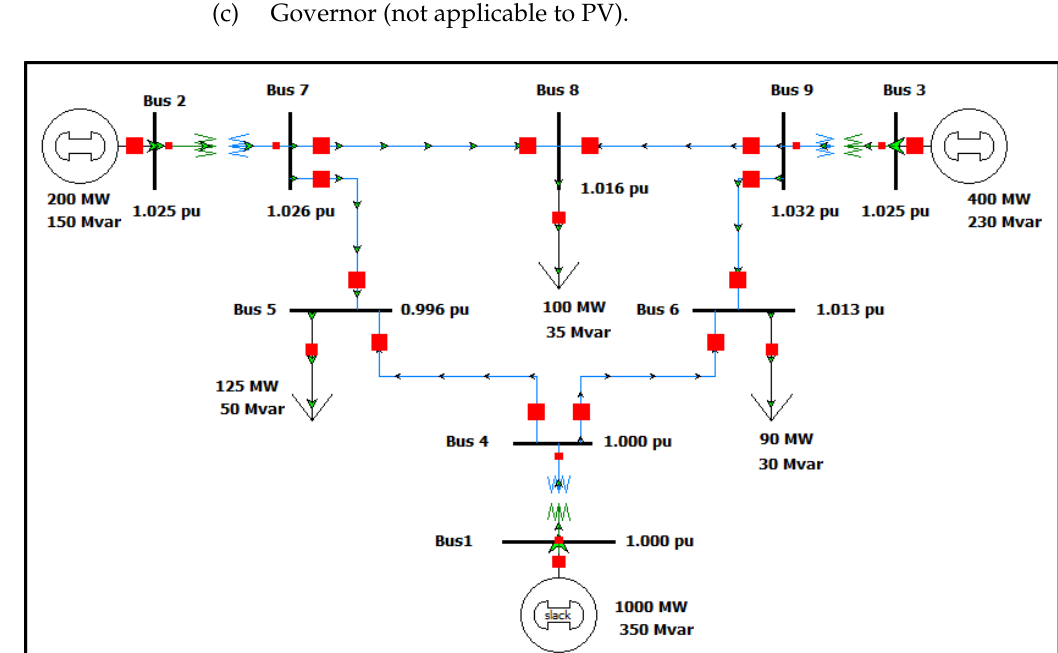
Figure 4. Power world network load flow model validation.